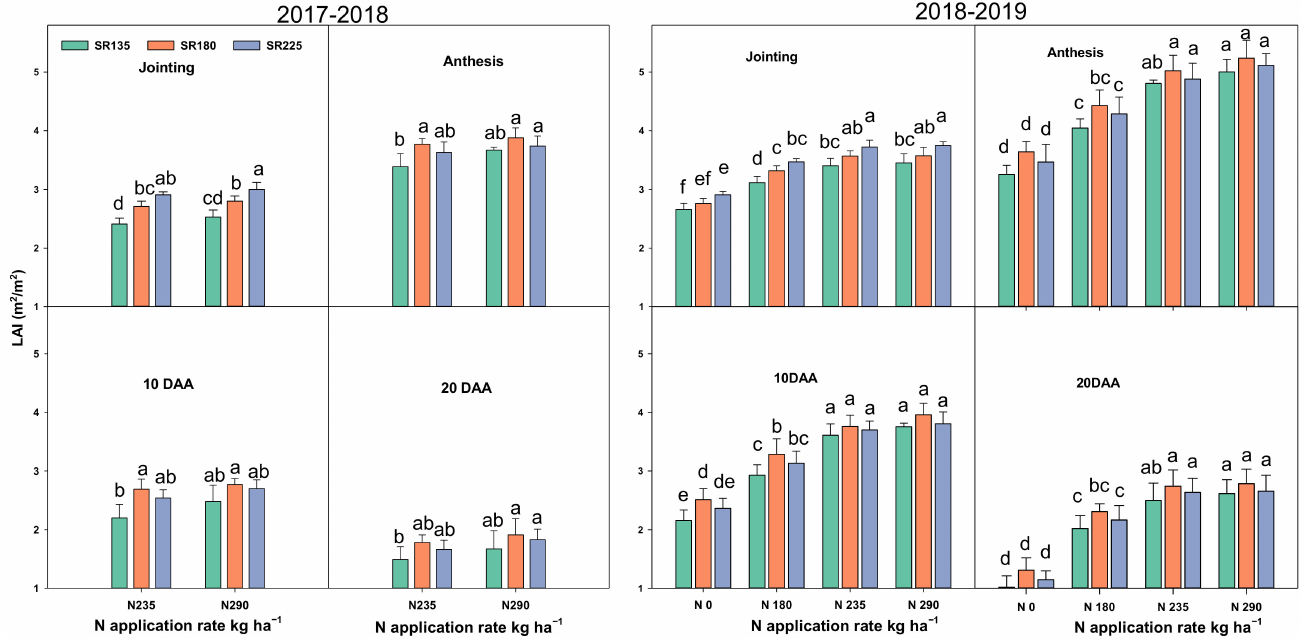
Figure 3. Effects of the combination of N and SR on the values of the leaf area index (LAI) during four differnet growing stages in 2017–2018 and 2018–2019. Different letters represent significant differences in mean values of three replicate plots at p ≤ 0.05 levels according to Duncan’s test.